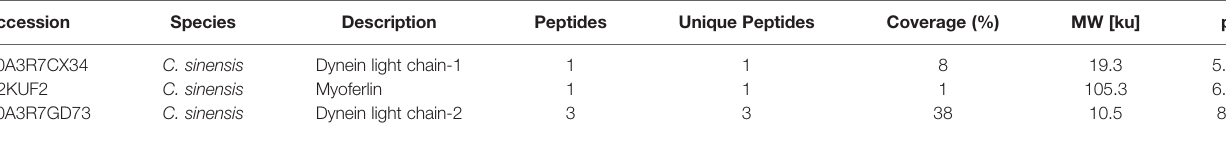
TABLE 5 | Clonorchis sinensis excretory and secretory products which were detected by rabbit post-infection in all four